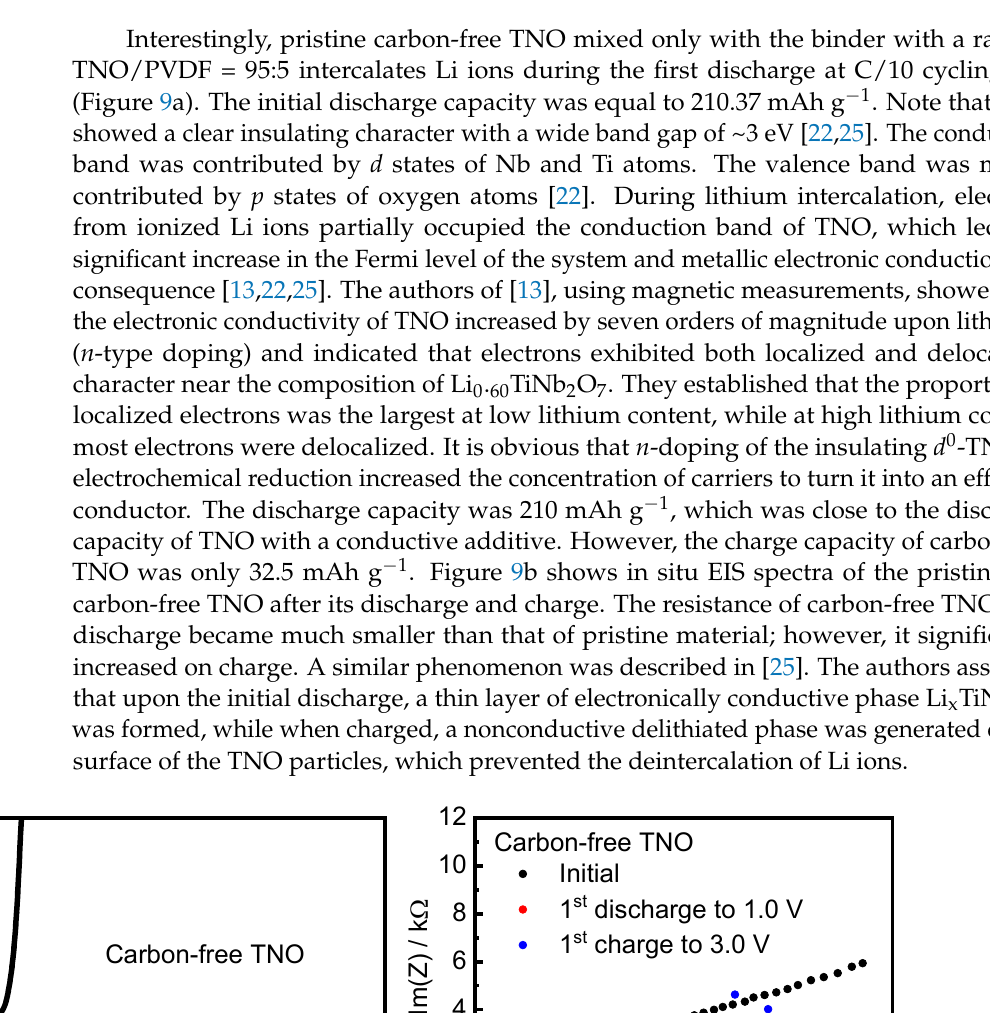
Figure 8. Electronic conductivity vs. frequency for TNO, TNO-MA, and TNO/C.